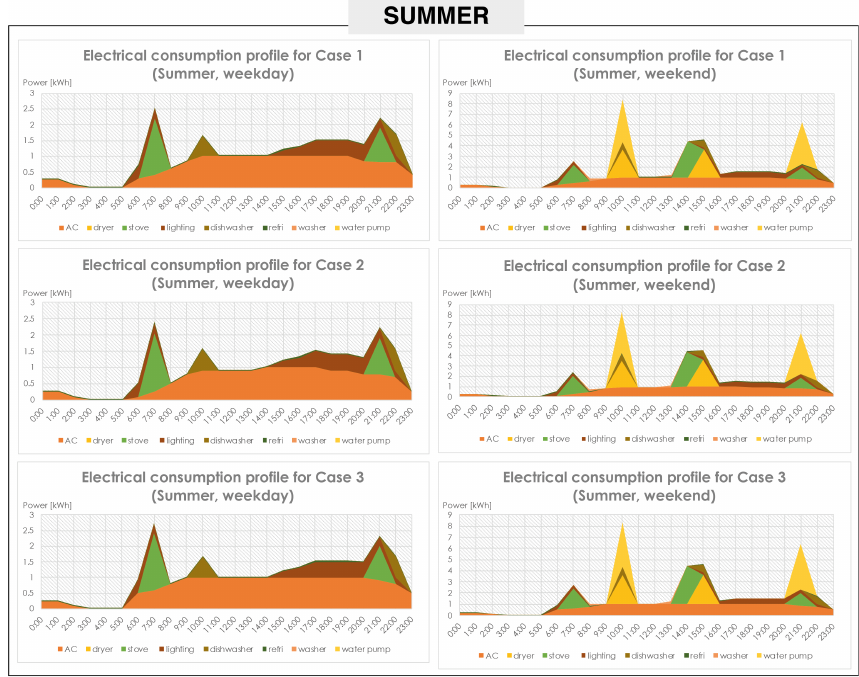
Figure 11. Daily average energy consumption in summer season for Case 1, Case 2, and Case 3 during weekday and weekend.